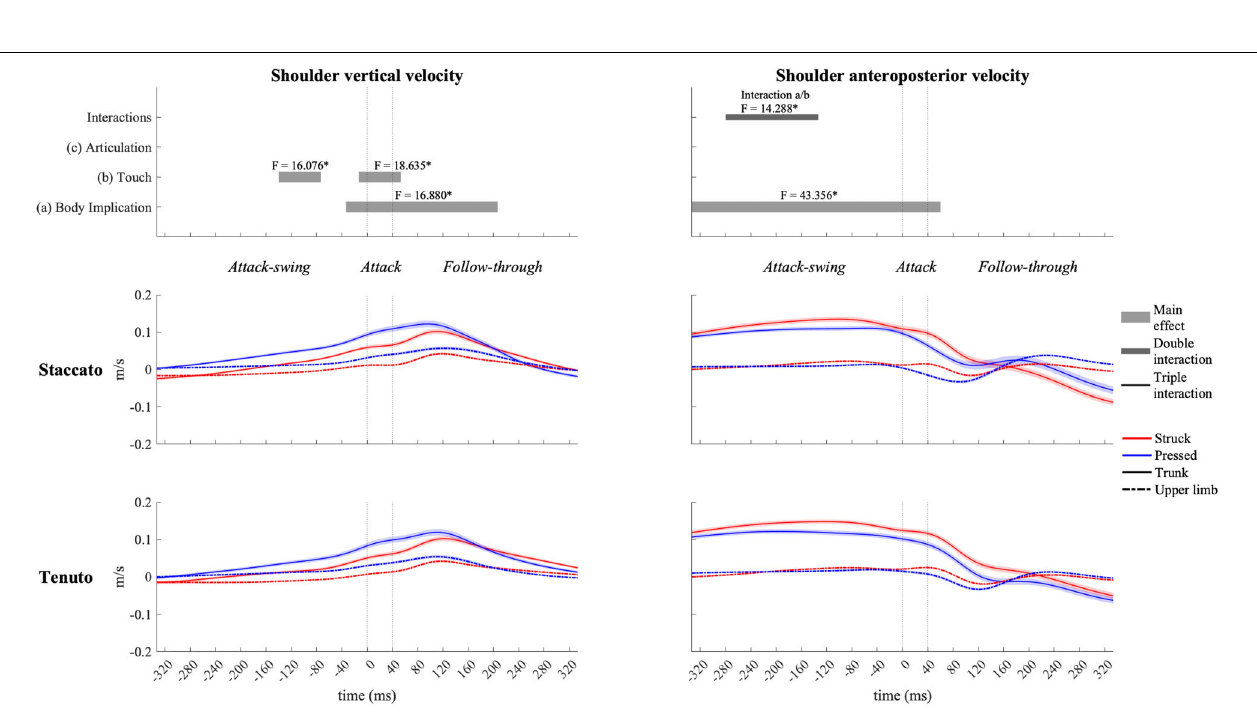
FIGURE 7 | Mean values (solid and dash-dotted lines) and 95% bootstrap confidence interval (shaded areas) of shoulder linear velocities during the three phases of the keystroke. Negative/positive values indicate downward/upward velocities and backward/forward velocities. Top panels represent the results from the statistical parametric mapping of time-series values. * p -value ≤